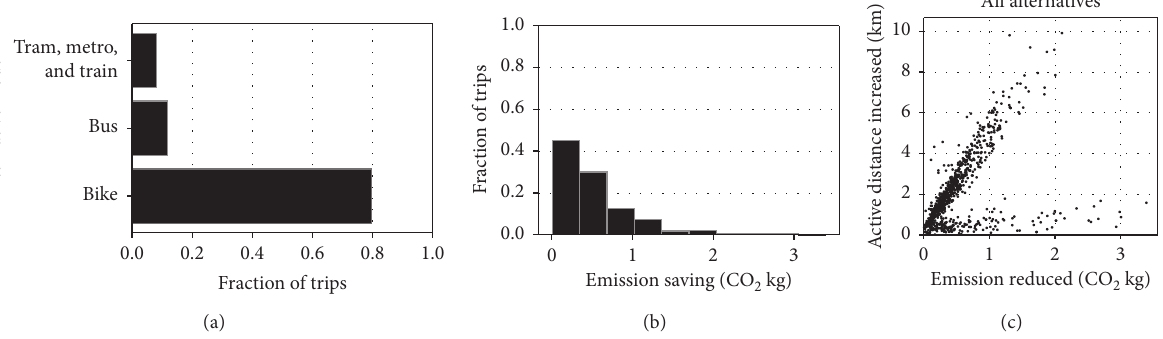
Figure 25: Modal shift from the unique car trips with consistent low-carbon time-relevant alternatives. Emission savings and increased travel distance of bike and walk.